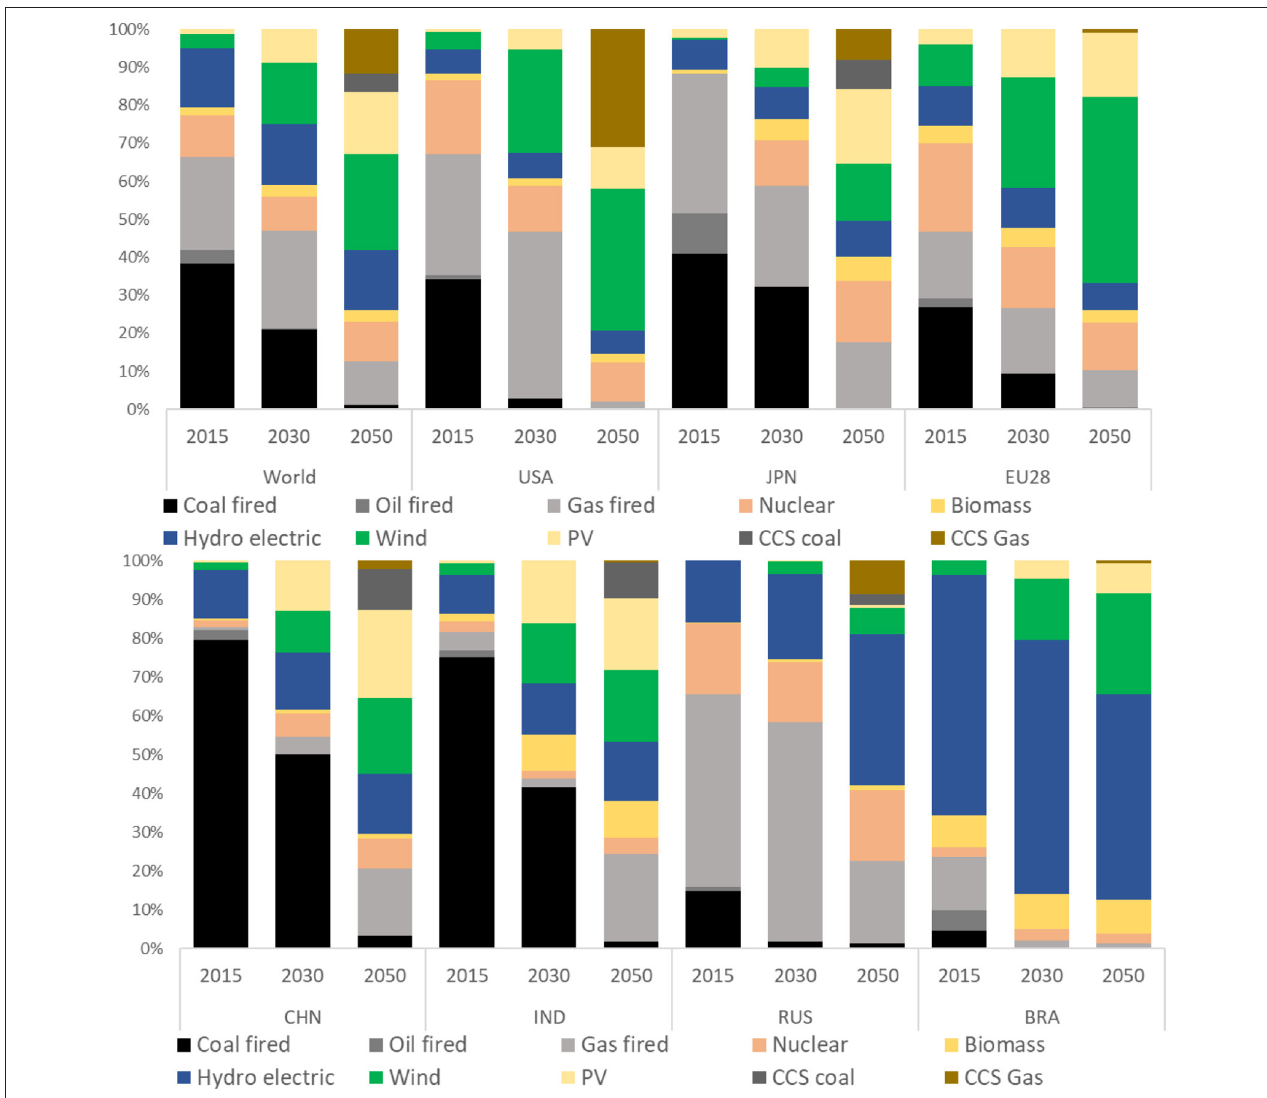
FIGURE 8 | Power generation mix in major economies in the 2DEG